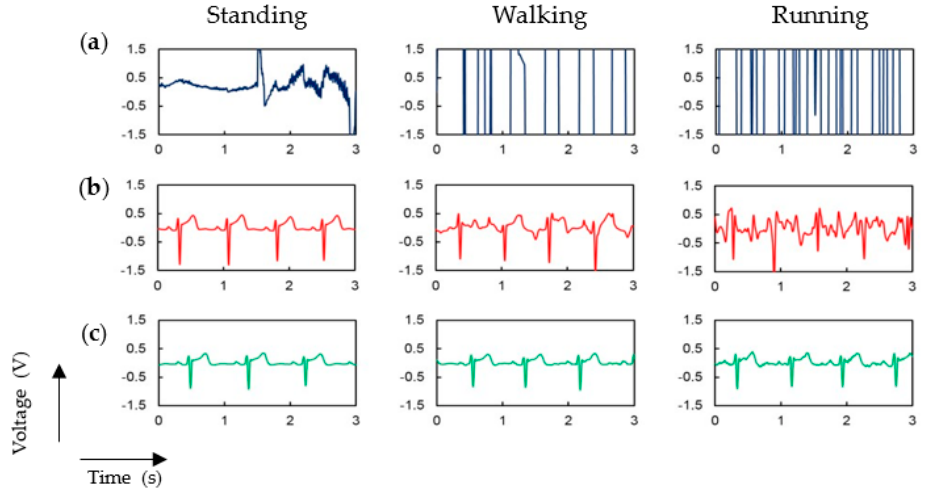
Figure 9. Measured ECG signal at three different levels of motion (standing, walking, and running) by using ( a ) ECG measurement garment without P-electrodes; ( b ) Ag/AgCl electrodes; and ( c ) ECG measurement garment with P-electrodes.